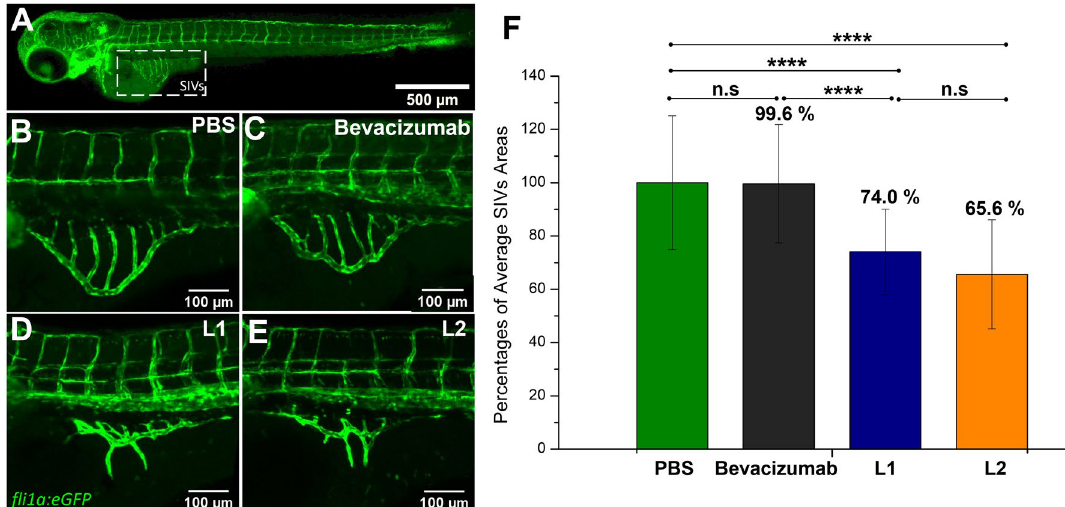
Figure 4. In vivo angiogenesis inhibition by L1, L2 and bevacizumab. ( A ) Lateral view of subintestinal vessels (SIVs) in fli1:EGFP transgenic zebrafish larvae at 3 dpf. ( B ) PBS (negative control) ( C ) 27.5 μM bevacizumab ( D ) 55 μM L1, ( E ) 55 μM L2 were injected into yolk of 2 dpf fli1:EGFP transgenic zebrafish embryos. At 3 dpf, zebrafish SIVs were imaged by confocal microscopy. ( F ) Percentages of average SIV areas were quantified. The outcomes are expressed as AVG ± SD. n PBS = 25, n bevacizumab = 24, n L1 = 24, n L2 = 23. Statistical analysis was performed using one-tail t-test. Statistical results: n.s. p > 0.05, ****p <